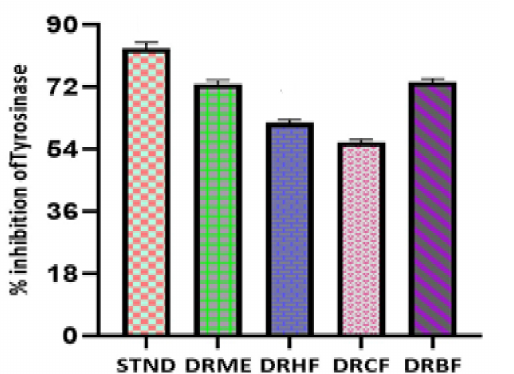
Figure 4. Tyrosinase inhibition of kojic acid (standard) and extract/fractions of Dracaena reflexa. STND: kojic acid (Standard); DRME: methanolic extract; DRHF: n -hexane fraction; DRCF: chloroform fraction; and DRBF: n -butanol